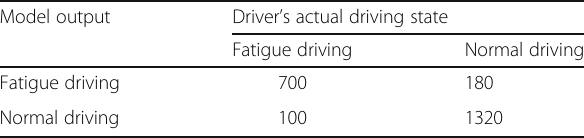
Table 1 Output of KNN model Model